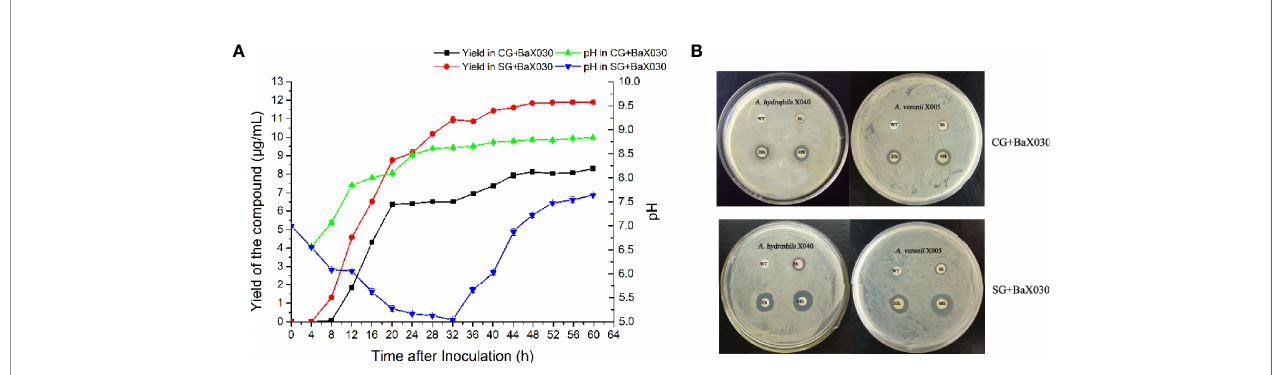
FIGURE 2 | The yield change graphand antibacterial of macrolactin A. (A) The yield curve of macrolactin A in two media. Datas were mean ± SEM for n=3 biologically independent experiments; (B) The antibacterialexperiment offermentation broth onAhX040 and AvX005 at differenttime points WT: Original mediumwithout